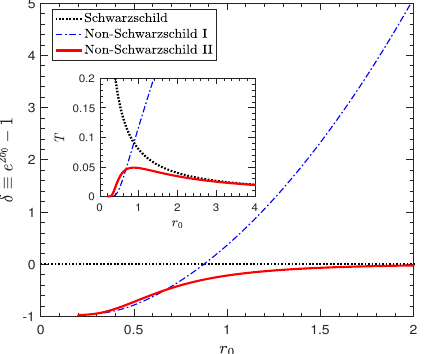
Figure 3 . δ vs r 0 for (non-)Schwarzschild black holes. The blue curve correspond to the branch of non-Schwarzschild black holes in refs. [12, 13], which intersect with the Schwarzschild solution ( δ = 0, black dotted) at r 0 0 . 876. The red solid curve is the non-Schwarzschild solution in this ≈ work. (Inset) The Hawking temperature T vs r 0 around intersection